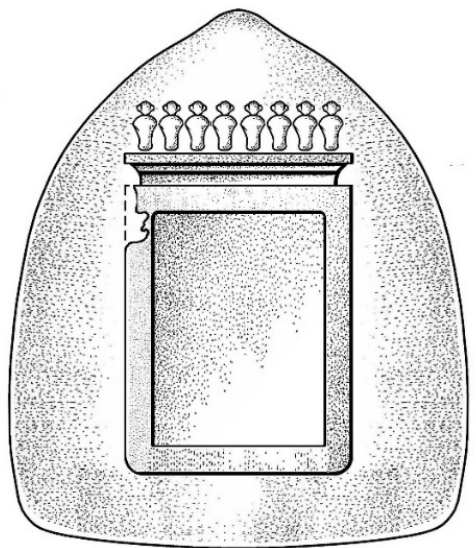
Figure 2. Clay portable shrine of the goldsmith Sankhuher, 12th century BCE, from Abydos in Egypt (Mariette 1880, p. 555).